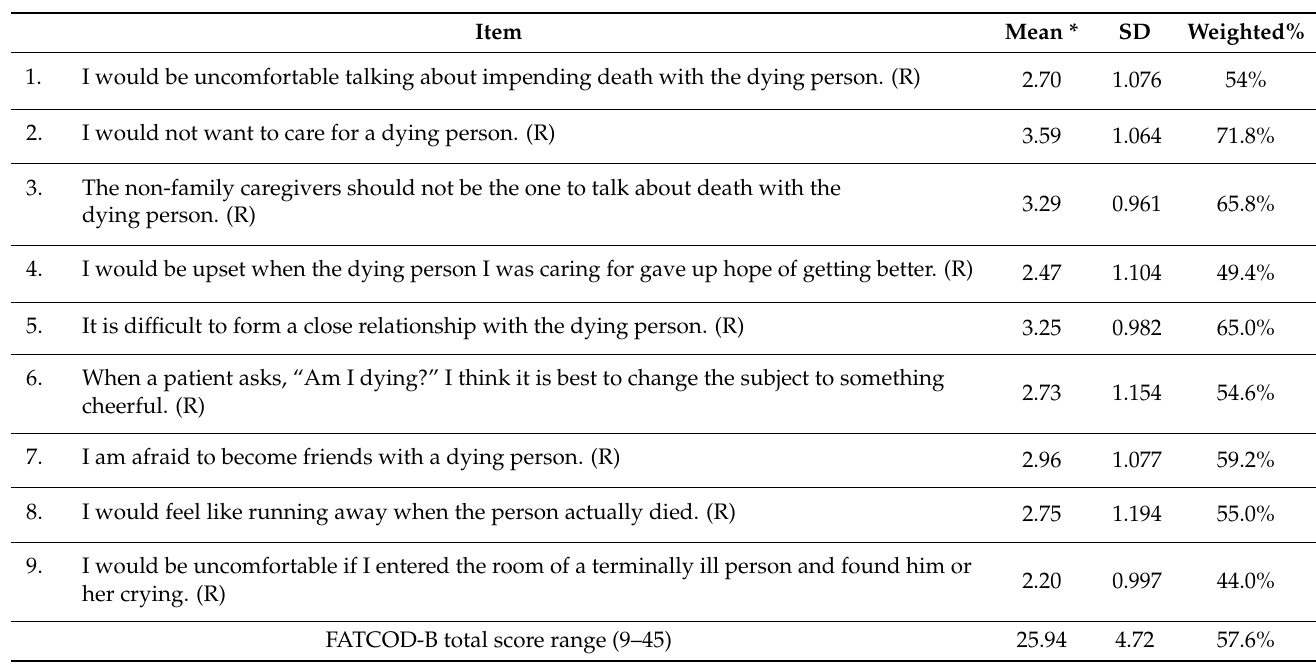
Table 3. Nursing students’ attitudes toward the care of the dying patient (n =